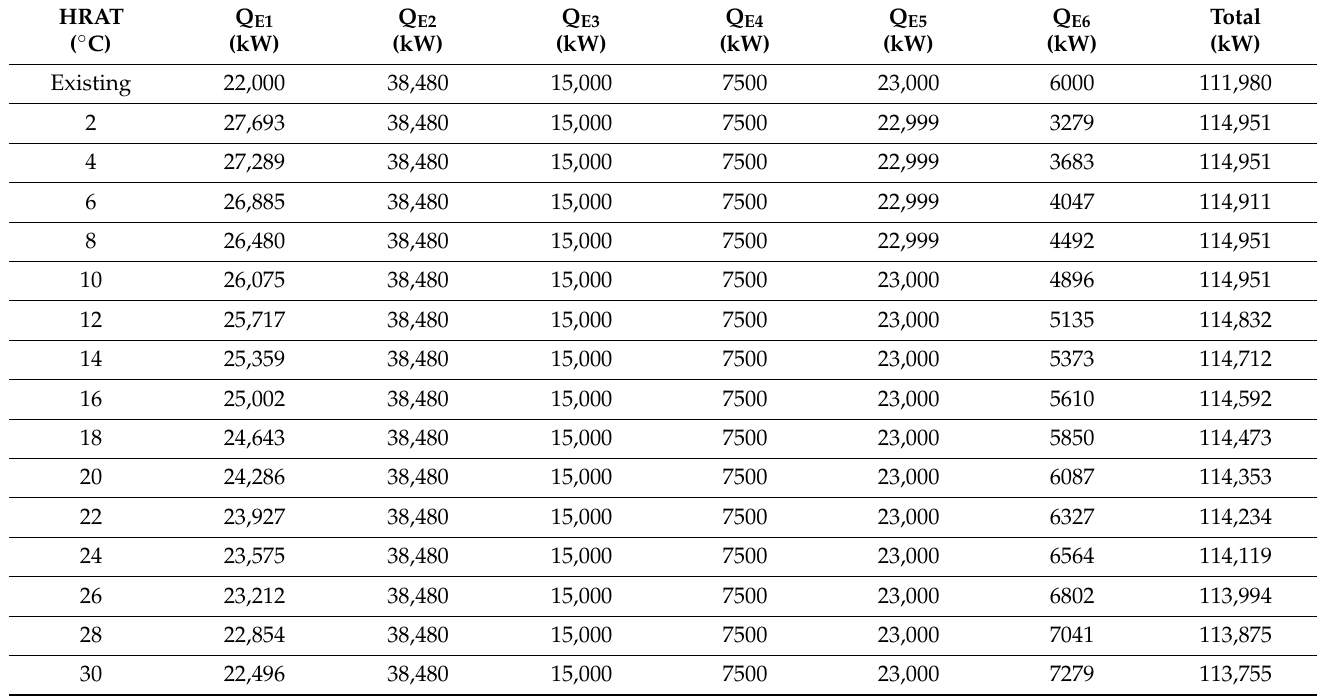
Table A3. Heat loads at different HRAT values for option